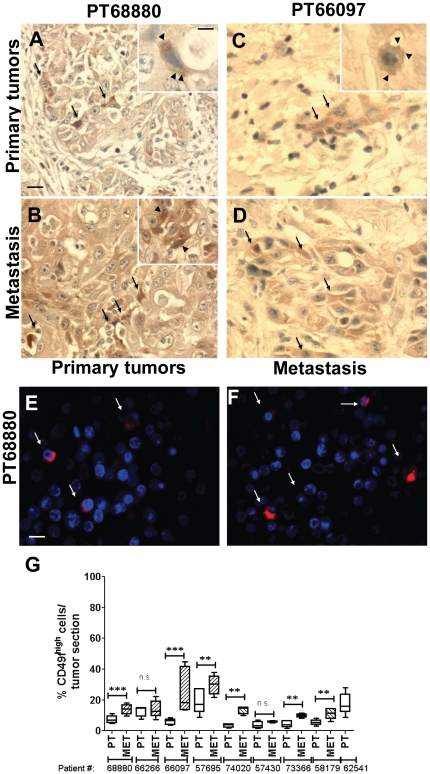
Primary tumors and metastasis from HNSCC patients contain a subpopulation of CD49fhigh cells.(A–D) Representative CD49f staining in primary tumors (A and C) and lymph node metastasis (B and D) from two different patients. CD49fhigh tumor cells are marked with arrows. Note the strong cytosolic and membrane pattern of the signal (arrowhead in the, inset) and the overall stronger signal and increased frequency for CD49f in the metastatic lesions (B and D). Scale bar: 80 µm and 40 µm inset scale bar. (E–F) Immunofluorescence detection of CD49f in sections from human oral primary tumors (E) and metastasis (F) (PT68880). Scale bar: 60 µm. (G) Quantification of CD49fhigh cells in sections from primary tumors and lymph node metastasis. Columns represent mean of 5 different sections per sample and a minimum of 500 cells was scored per sample. p-values estimated using one-way ANOVA followed by the Bonferroni correction with two-tailed P values<0.05 considered significant.